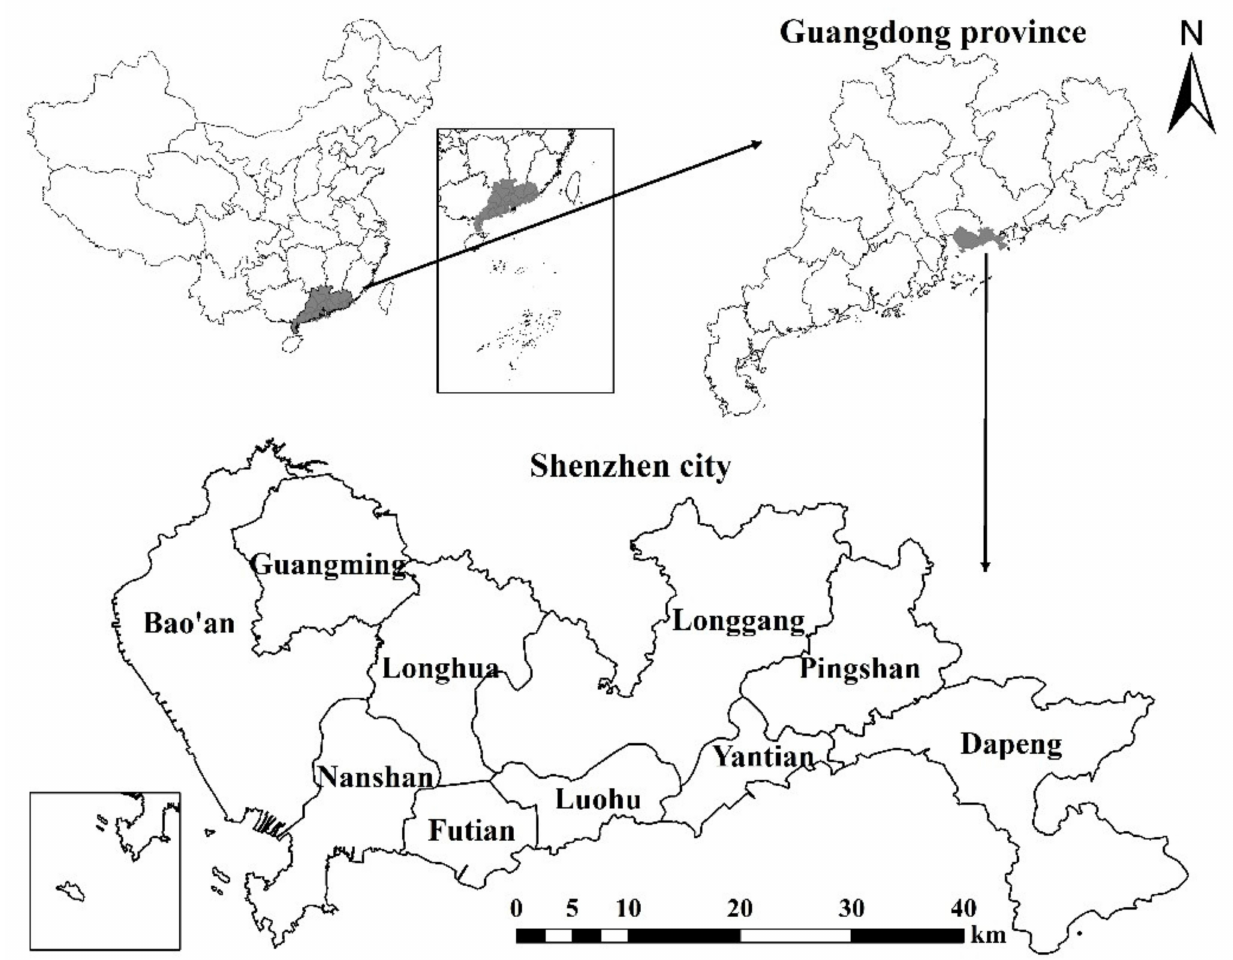
Figure 1. Location of Shenzhen